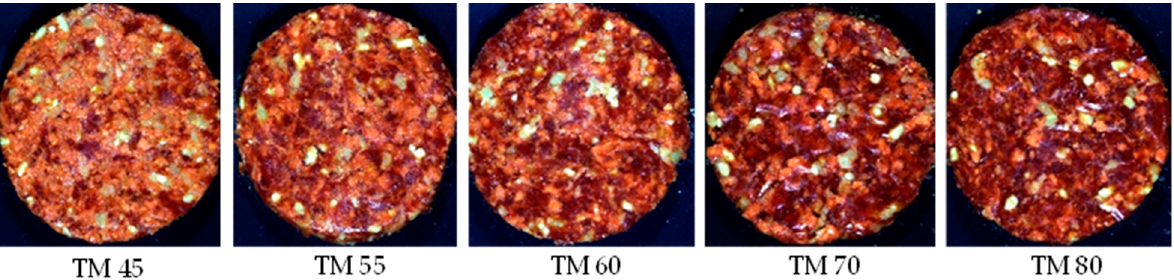
Figure 3. Digital images of the various total meat (TM) percentages for Patty 3 (value burger/value patty/value hamburger/value meatball/value frikkadel/Any other similar name).